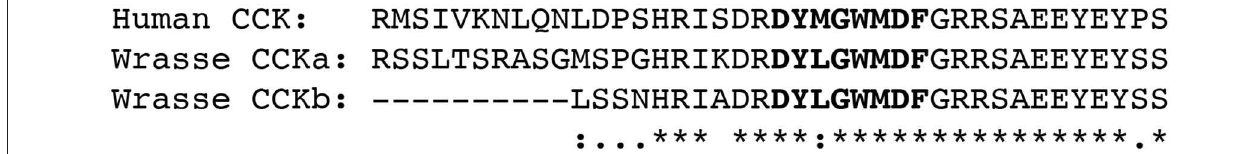
FIGURE 2 | Alignment of the human CCK preproprotein (NP 000720.1) with the two CCK preproprotein isoforms from ballan wrasse CCKa (ENSLBEG00000007237) and CCKb (ENSLBEG00000024541). The CCK-8 fragment is highlighted in bold. Asterisk (*) indicates positions which have a single, fully conserved residue, colon (:) indicates conservation between groups of strongly similar properties—scoring > 0.5 in the Gonnet PAM 250 matrix and period (.) indicates conservation between groups of weakly similar properties—scoring = < 0.5 in the Gonnet PAM 250 matrix.